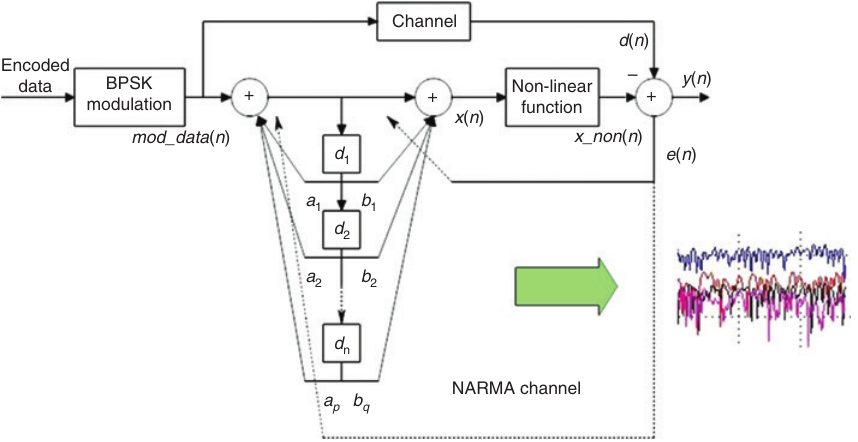
Figure 3: Signal Modeling in NARMA